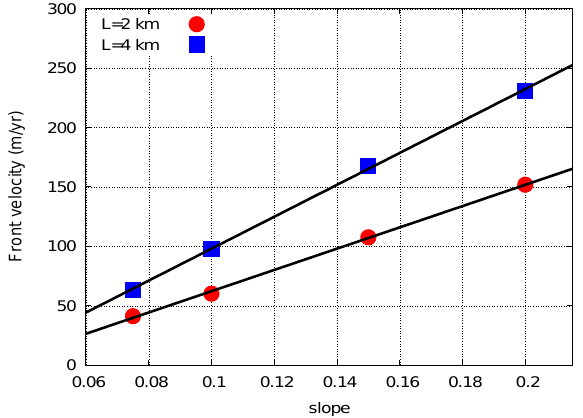
Fig. 6. Variation of velocity of the front as a function of slope for two different values of L 0 .